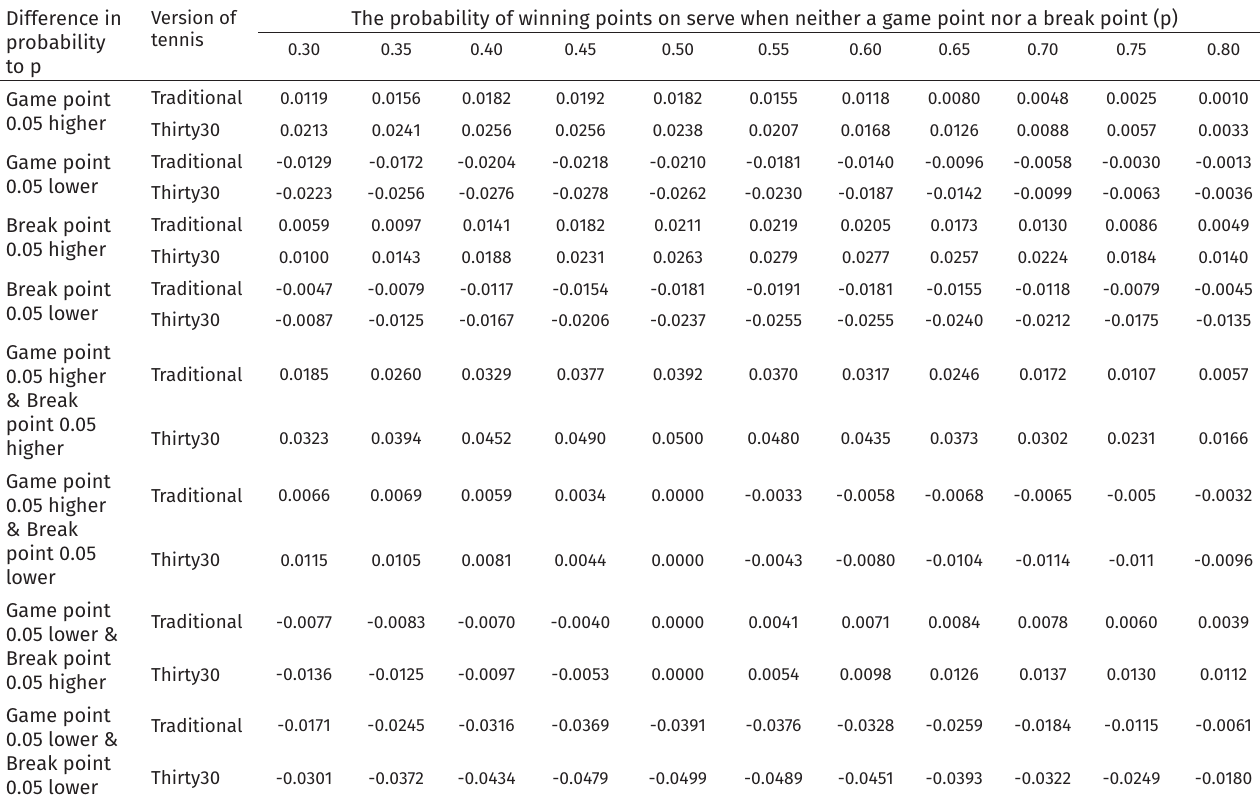
Table 2. Change in the probability of a player holding serve when their probability of winning game or break points is 0.05 higher or lower than when playing any other point on